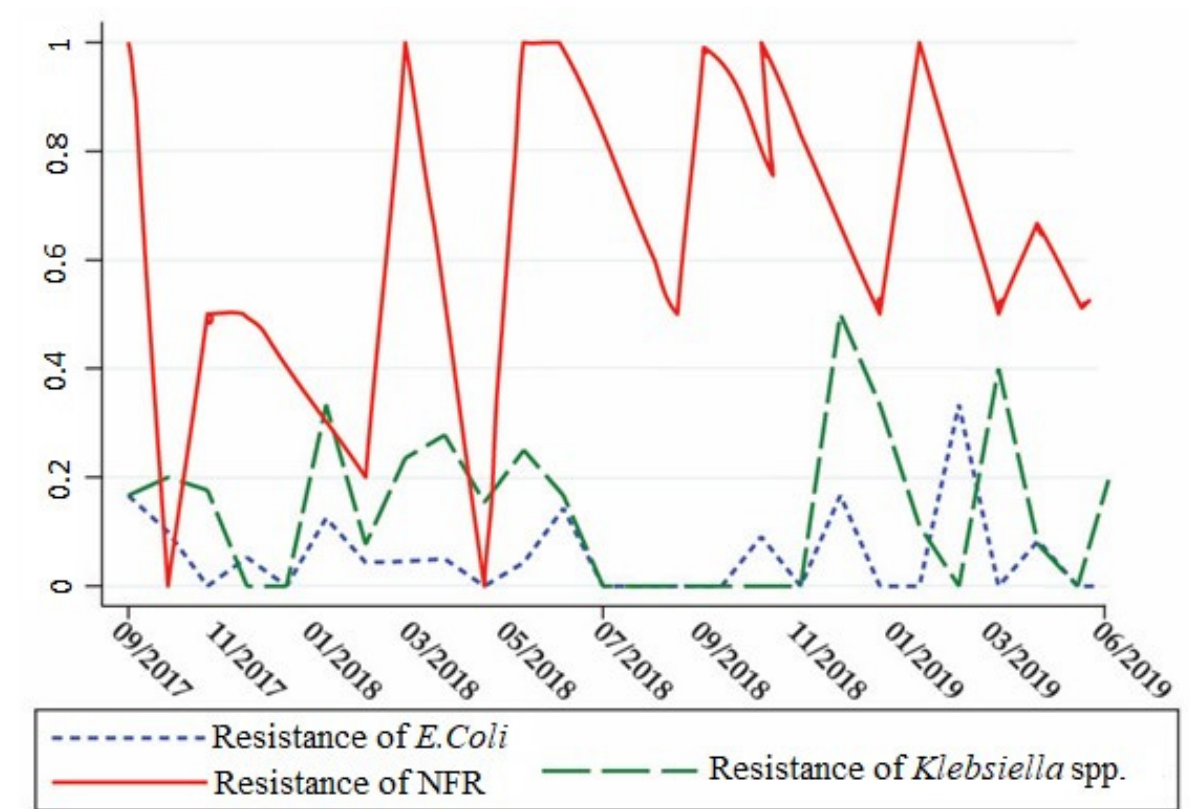
Figure 6. Monthly evolution of Meropenem resistance in E. coli, Klebsiella , and Gram-negative non-fermenter rods (NFR). Taking into account the monthly resistance index, Klebsiella resistance correlated with E. coli (r = 0.5107, p < 0.0214), as Klebsiella is a known plasmid collector of resistance from